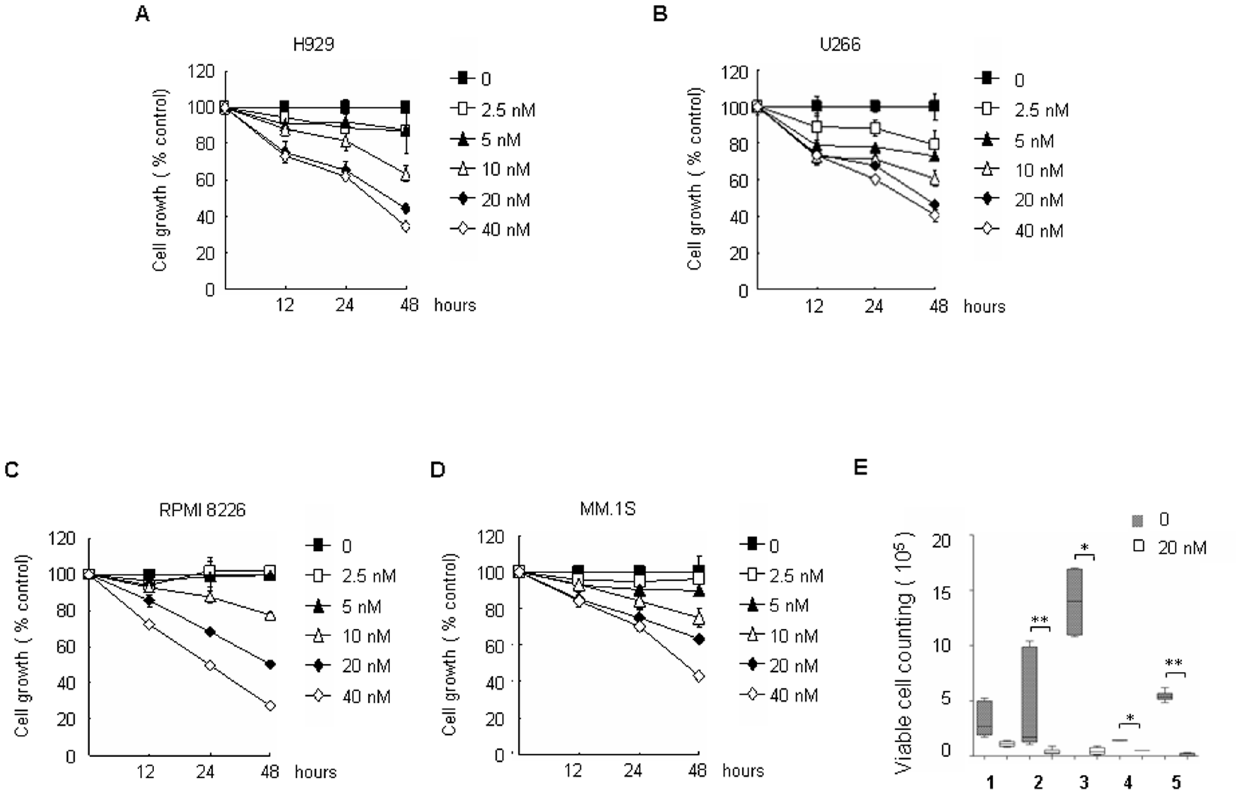
Figure 3. Bufalin inhibits MM cells proliferation. (A–D) Cells were seeded in 96-well plates and treated with different concentrations of bufalin for 12, 24 and 48 h. Bufalin-induced effects on cell proliferation were measured by CCK8 assay. All values represent means 6 S.D. of three independent experiments, each performed in triplicate. (E) CD138 + cells isolated from MM patients were incubated with 20 nM bufalin for 15 days as described in ‘‘Materials and Methods’’. Cells were collected, and viable cells were counted under a microscope using 0.4% Trypan blue stain. A box plot showing the 5th and 95th percentiles, together with the median, with showing the minimum and maximum difference in the percent slide- positivity rates among duplicates, the Mann-Whitney-Wilcoxon test was used to compare untreated control and treated samples ( * P , 0.05, ** P , 0.01, compared to the controls).